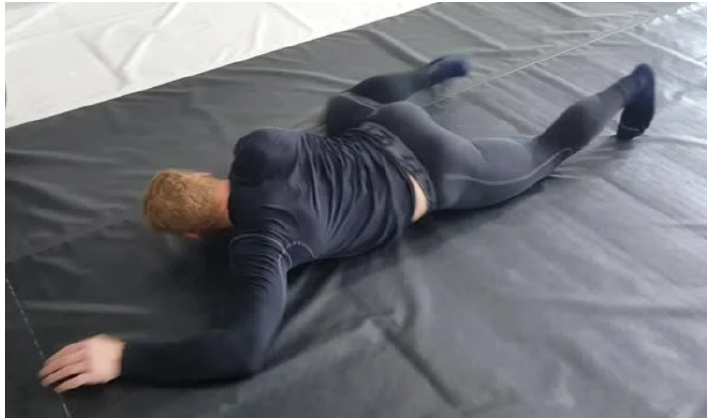
Figure 1. Example of military crawling.